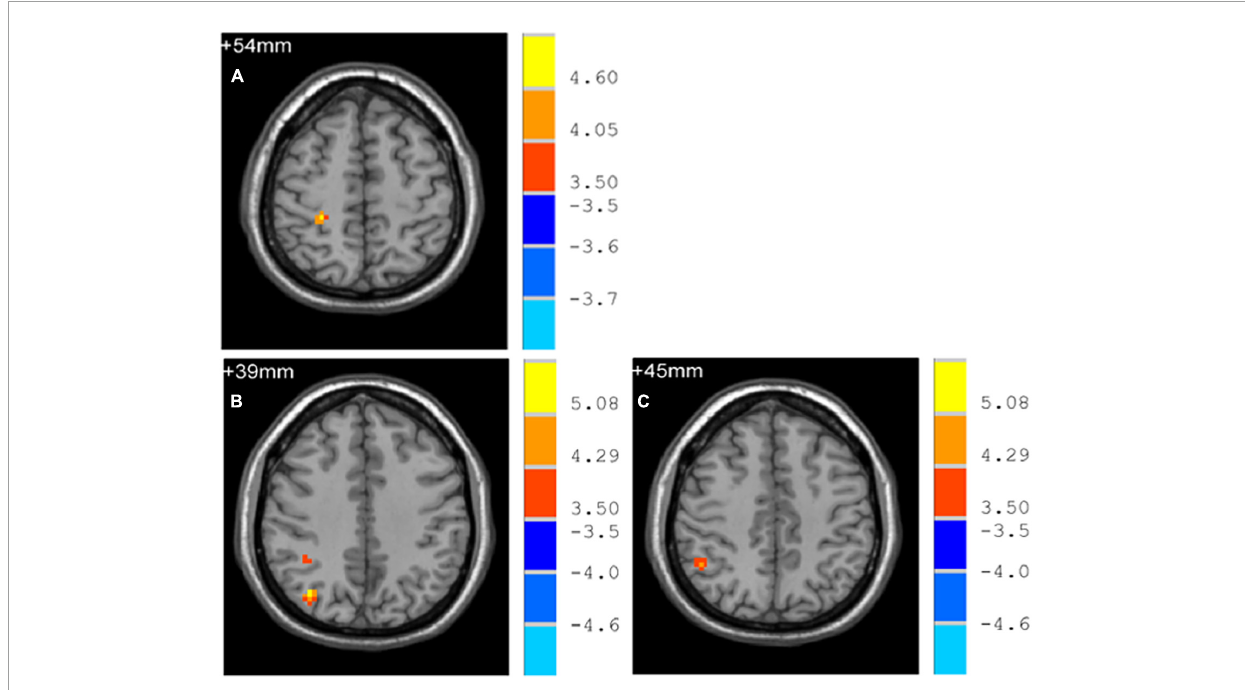
FIGURE3 Brain regions with altered intra-networks functional connectivity in EOPD. (A) Right post-central gyrus. (B) Right angular gyrus. (C) Right inferior parietal gyrus. Yellow and red represent brain regions with significantly increased intra-networks functional connectivity in EOPD. Two-sample t -tests results are presented ( p < 0.05, AlphaSim corrected).